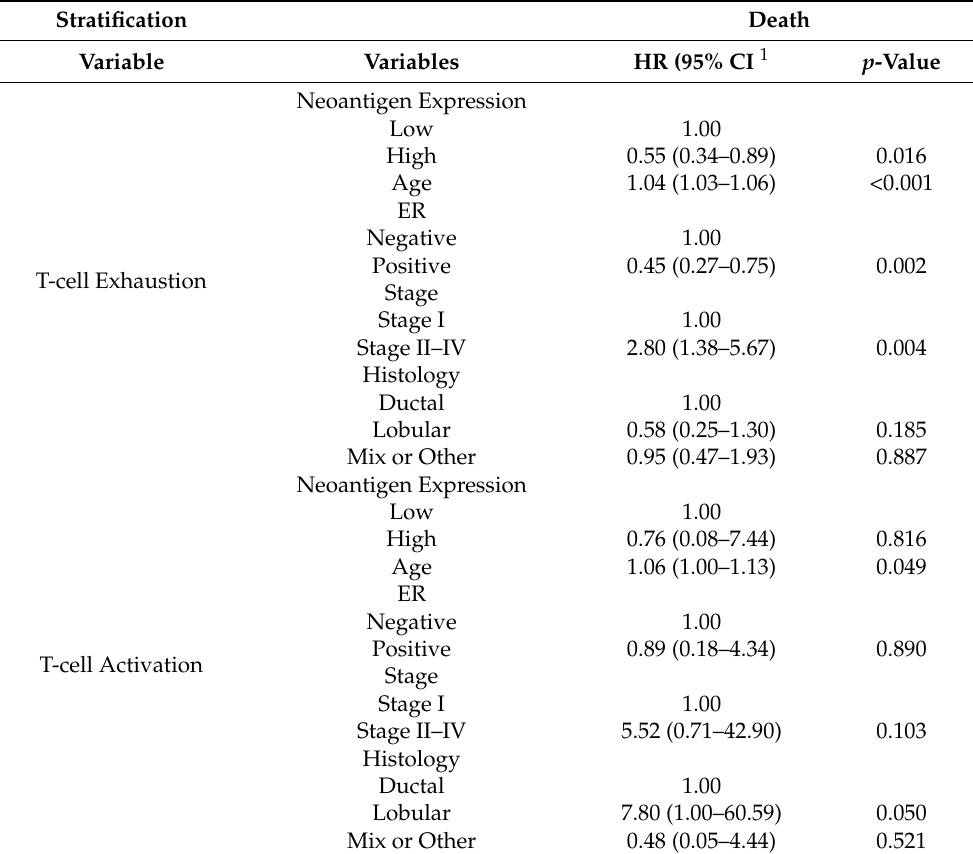
Table 3. Association between neoantigen expression and overall survival stratified by T-cell activa- tion